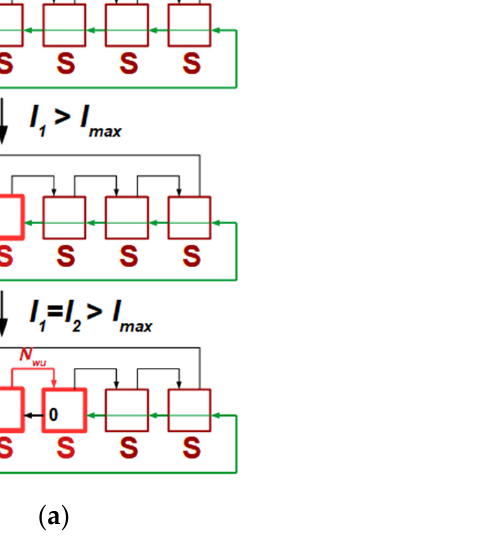
Figure 5. LCs status depending on current threshold crossings: ( a ) enabling sequence for an increasing output current; ( b ) disabling sequence for a decreasing output current (M: the Master LC; S: a Slave LC; SM : the Master/Slave bit indicator intended to manage enabling/disabling sequences, such as chase sequences).